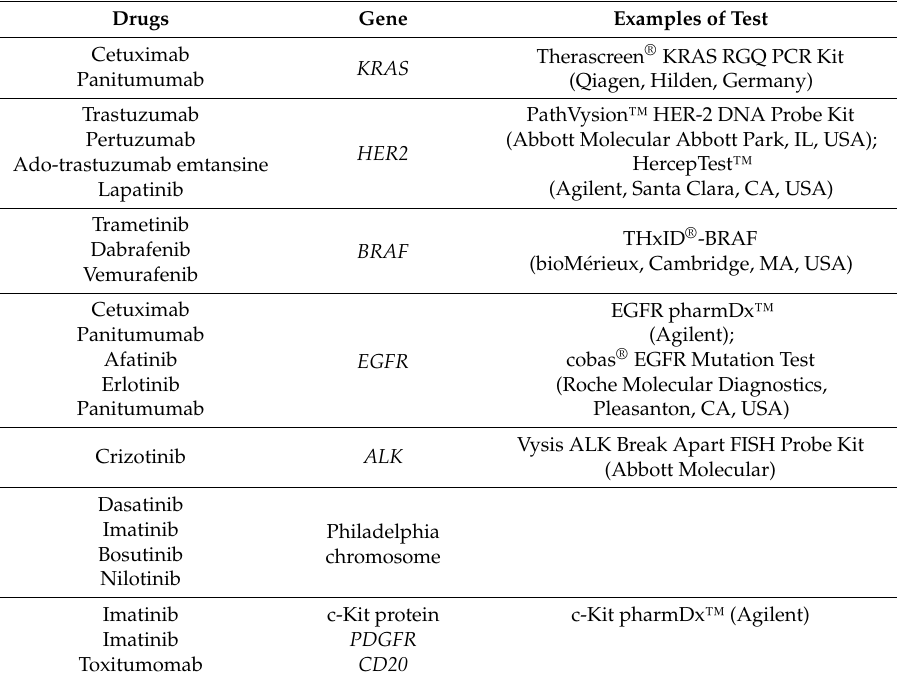
Table 1. Study drugs and pharmacogenomic